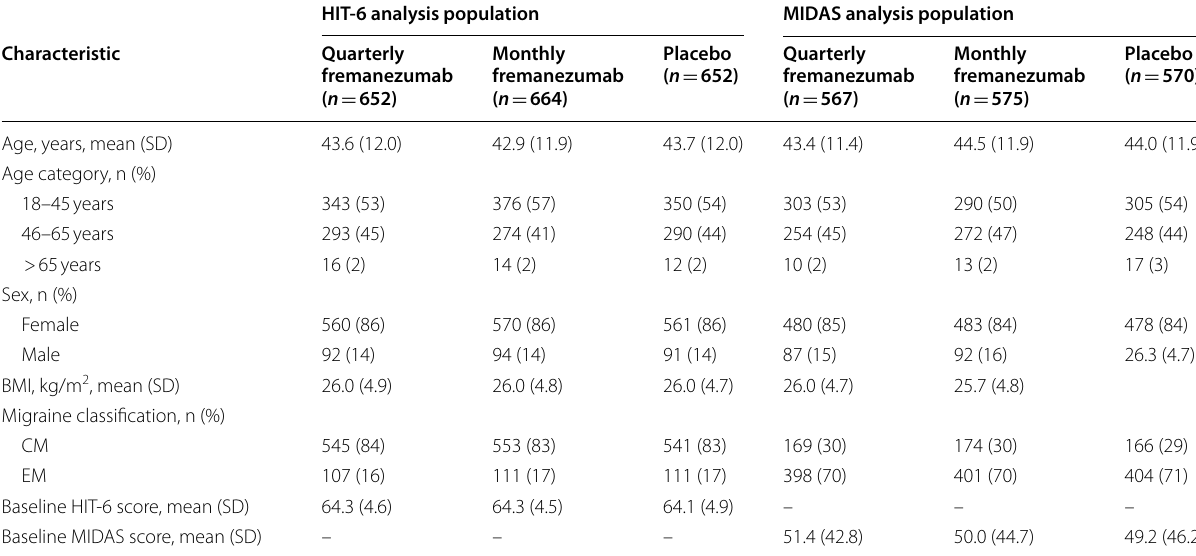
Table 2 Baseline and demographic